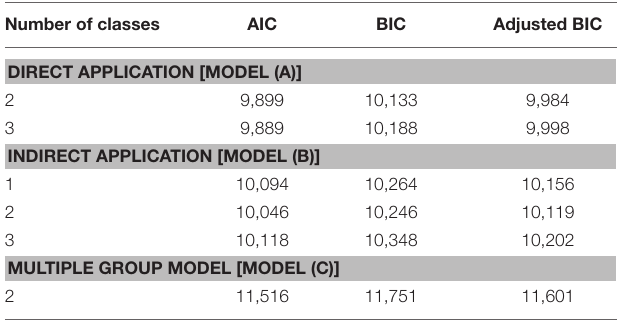
TABLE 1 | Model fit indices for the three